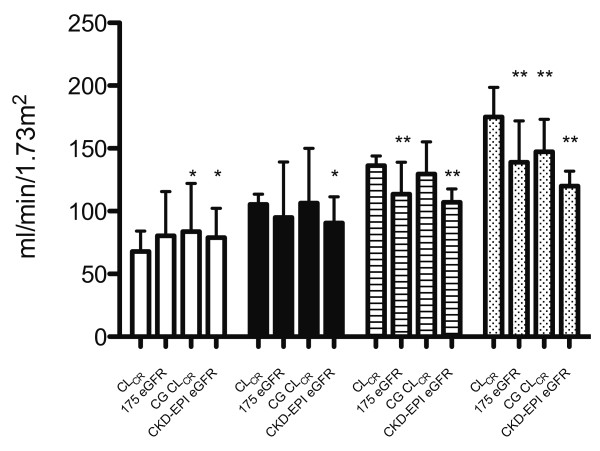
Comparison of CLCR with mathematical estimates over different ranges. CLCR compared with 175 eGFR, CG CLCR, and CKD-EPI eGFR over different ranges. CLCR < 90 (open), 90–119 (solid), 120–149 (lines), and ≥ 150 (dots) ml/min/1.73 m2. * P < 0.05, ** P < 0.001. CLCR = 8-hr Creatinine Clearance, 175 eGFR = Abbreviated Modification of Diet in Renal Disease 175 formula, CG CLCR = Cockcroft-Gault Creatinine Clearance, CKD-EPI eGFR = Chronic Kidney Disease Epidemiology Collaboration Equation.